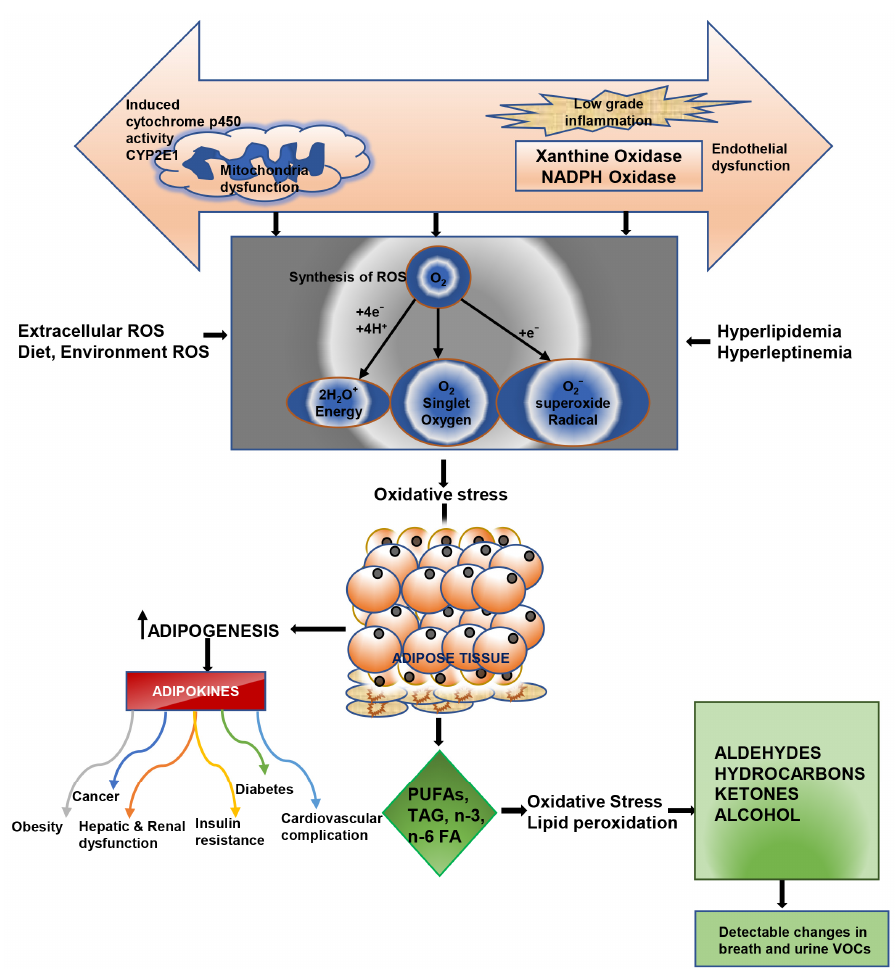
Figure 2. Model showing interconnection between oxidative stress and volatile organic compounds production in obesity.